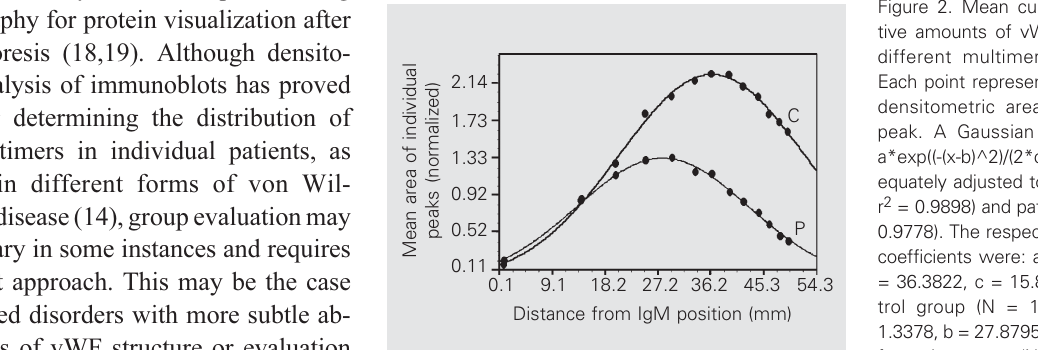
Figure 2. Mean curves for rela- tive amounts of vWF protein in different multimeric fractions. Each point represents the mean densitometric area of a given peak. A Gaussian model [y = a*exp((-(x-b)^2)/(2*c^2))] was ad- equately adjusted to controls (C, r 2 = 0.9898) and patients (P, r 2 = 0.9778). The respective equation coefficients were: a = 2.2321, b = 36.3822, c = 15.8908 for con- trol group (N = 15), and a = 1.3378, b = 27.8795, c = 14.6598 for patient group (N =